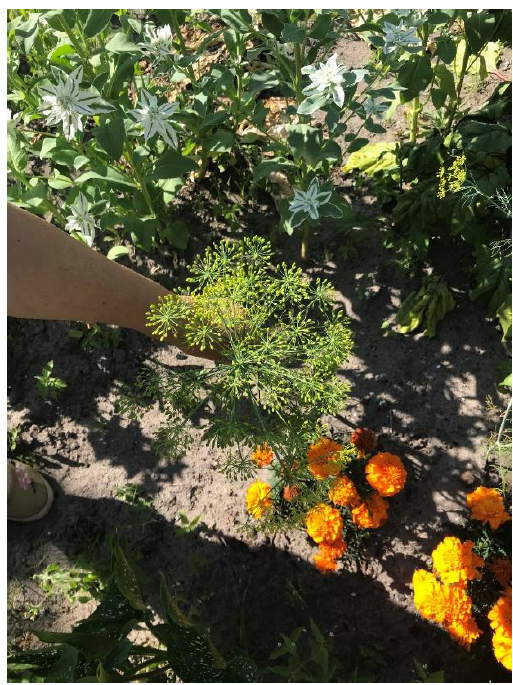
Figure 8. Home garden, Tauragė District, Lithuania, (everything together — for medicine, food and decor).